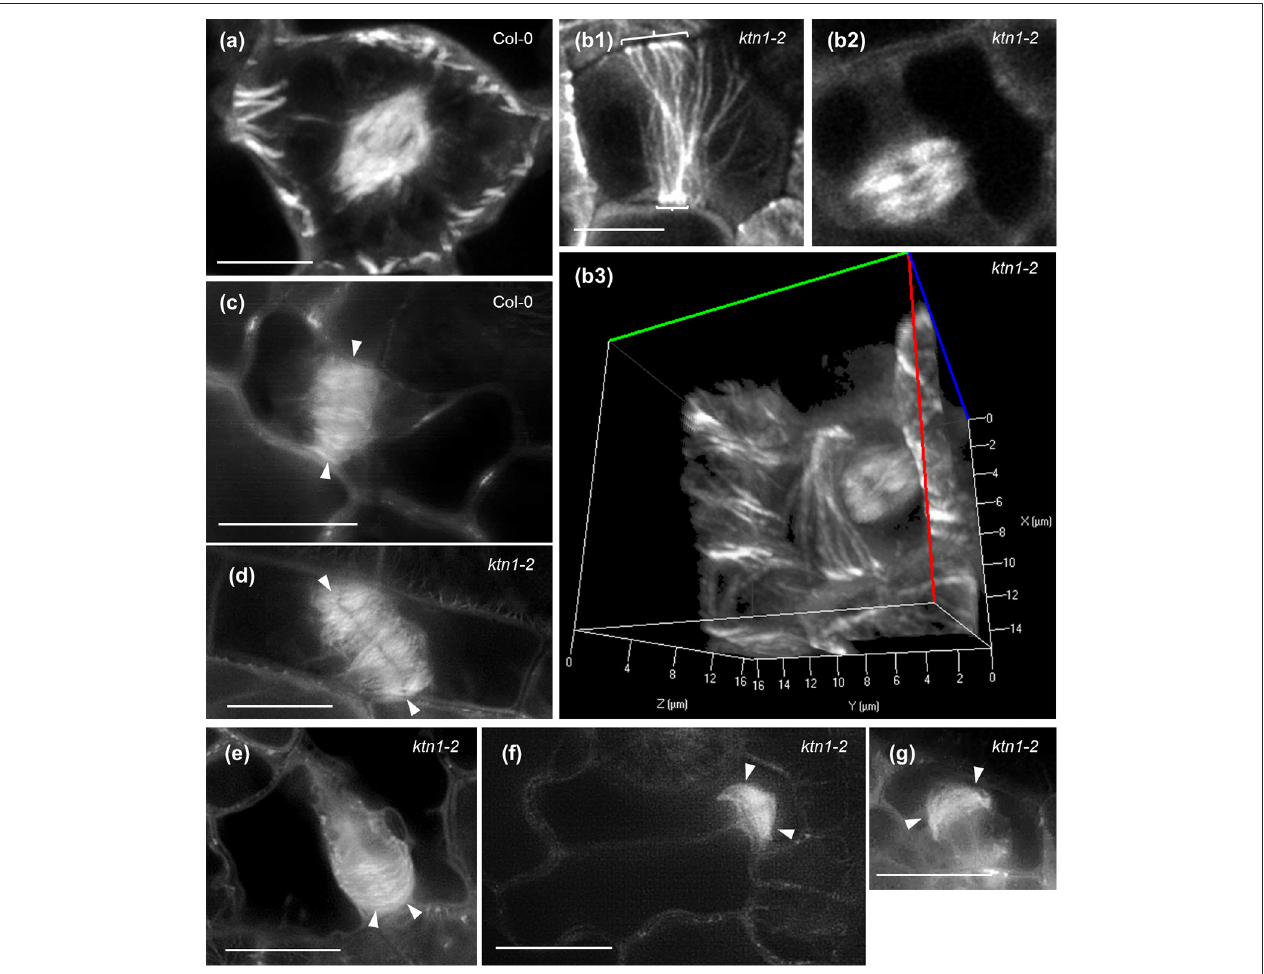
FIGURE 8 | Mitotic and cytokinetic forms in Col-0 and ktn1-2 mutant expressing a GFP-TUA6 microtubule marker after Airyscan CLSM (a,b) and SIM (c–g) imaging of single optical sections (b1,b2,c–g) or after 3D reconstruction (a,b3). (a) Typical prophase spindle in Col-0. (b) A typical bipolar metaphase spindle of ktn1-2 which is formed in the presence of a broad PPB (brackets, b1,b2 ) at the cell cortex and a 3D rendered image of the same cell (b3) which corresponds to a panoramic 3D rotation of Video S7 . Scanning time of the entire Z-stack (93 sections) was 5.9min. (c) Typical phragmoplast of Col-0 (arrowheads). (d) An oblique phragmoplast of ktn1-2 (arrowheads). (e) An advanced phragmoplast (arrowheads) of ktn1-2 progressing asymmetrically toward the parent wall. (f) A similarly asymmetric phragmoplast of ktn1-2 showing “arrowhead” configuration (arrowheads). (g) A shorter, advanced ktn1-2 phragmoplast again with “arrowhead” configuration (arrowheads). All scale bars: 10 µ